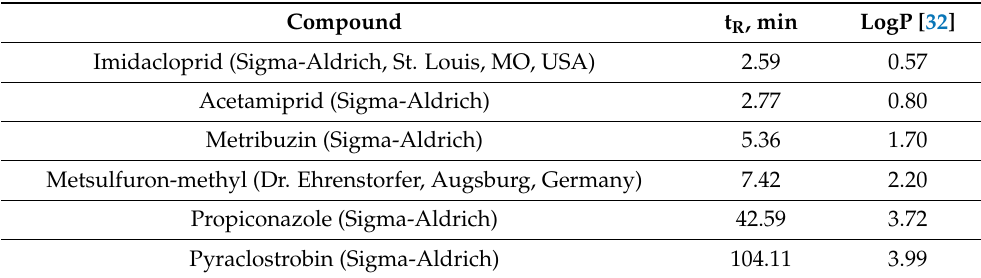
Table 1. Calibration standards for determination of